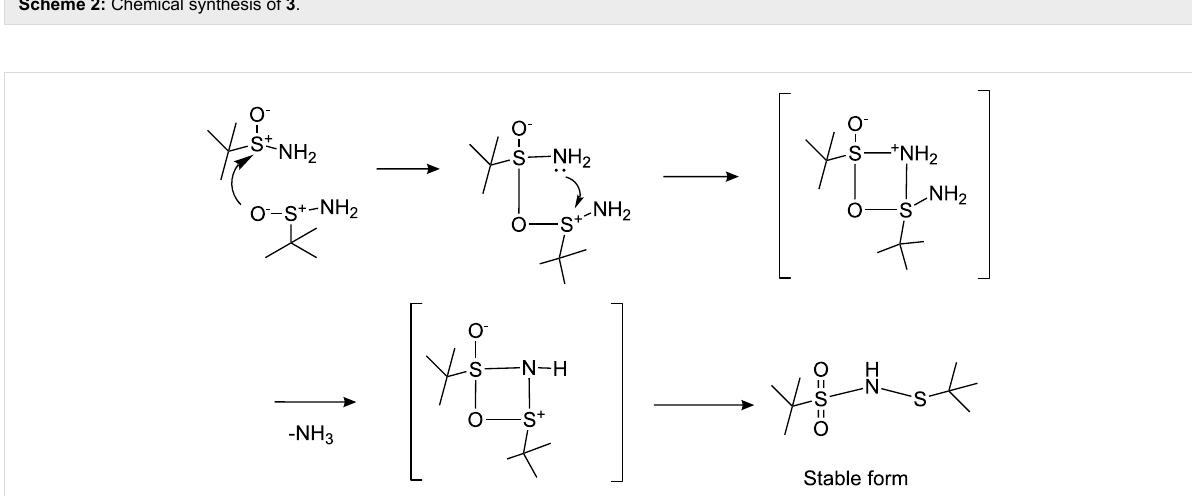
Scheme 2: Chemical synthesis of 3 .